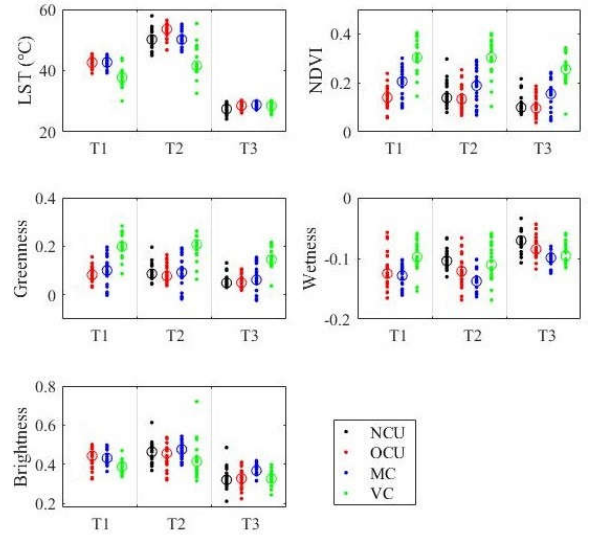
Figure 2 . Comparisons among four types of residential community in LST and related variables, including Greenness, Wetness, Brightness, and NDVI. T1, T2, and T3 indicate the date of imagery acquisitions, which were 04 August 2013, 25 July and 16 December 2021 respectively. The NCU communities were not considered on T1. In this figure, the dots represent the values of corresponding variable for individual communities, while the circles indicate the median values correspondingly.